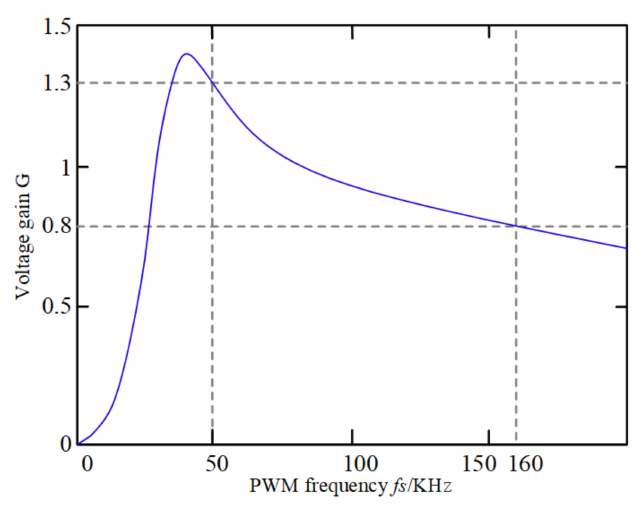
Figure 6. Fundamental equivalent method voltage gain curve.